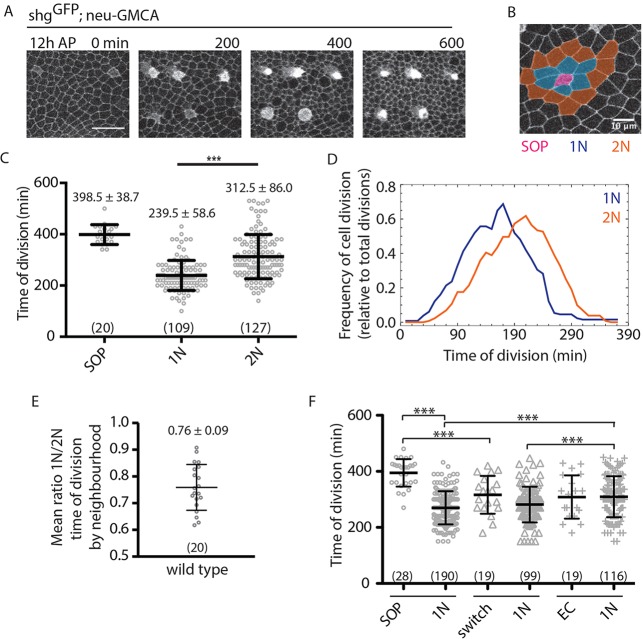
Spatiotemporal patterning of notum cell divisions. (A) Pupal notum expressing ShotgunGFP (cell boundaries), and nGMCA (SOPs) over time. Posterior to the left, anterior to the right. Scale bar: 25 µm. (B) SOP ‘neighbourhood’: SOP (pink) with primary (1N; blue) and secondary (2N; orange) neighbours. Scale bar: 10 µm. (C) Time of cell division for the genotype shown in A; N=2 pupae. (D) Line graph of the data shown in C. (E) Mean ratio of local SOP neighbourhood division timing, genotype as in A. N=2 nota; n=20 SOPs, 109 1Ns, 127 2Ns. (F) Division timing of SOPs, ‘switch’ cells (neu-GMCA-expressing cells that switch to EC fate) and ECs and their respective 1Ns in shotgunGFP; neu-GMCA pupae (N=3). ***P<0.001 (unpaired two-tailed t-test for pairs indicated). Mean±s.d. shown. (n)=number of cells.